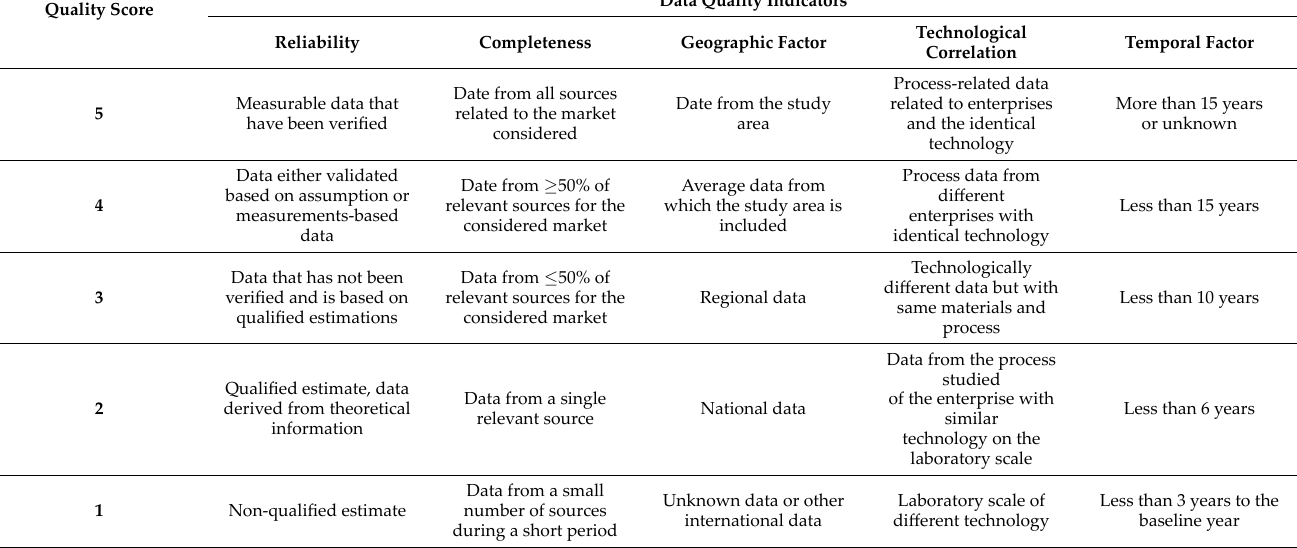
Table 8. DQI evaluation